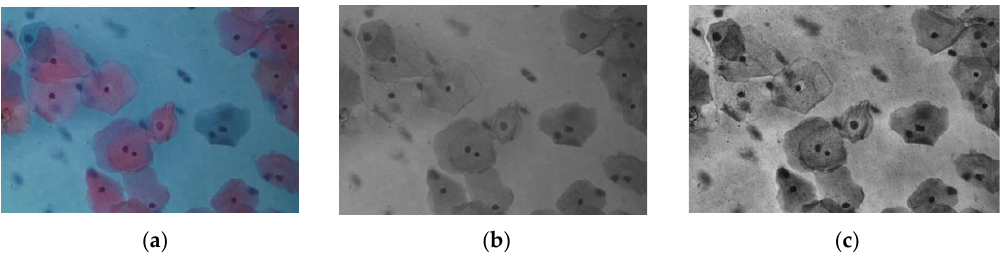
Figure 5. Image enhancement, ( a ) original image, ( b ) noise removal by the medial filter, and ( c ) contrast enhancement by CLAHE (contrast limited adaptive histogram equalization).